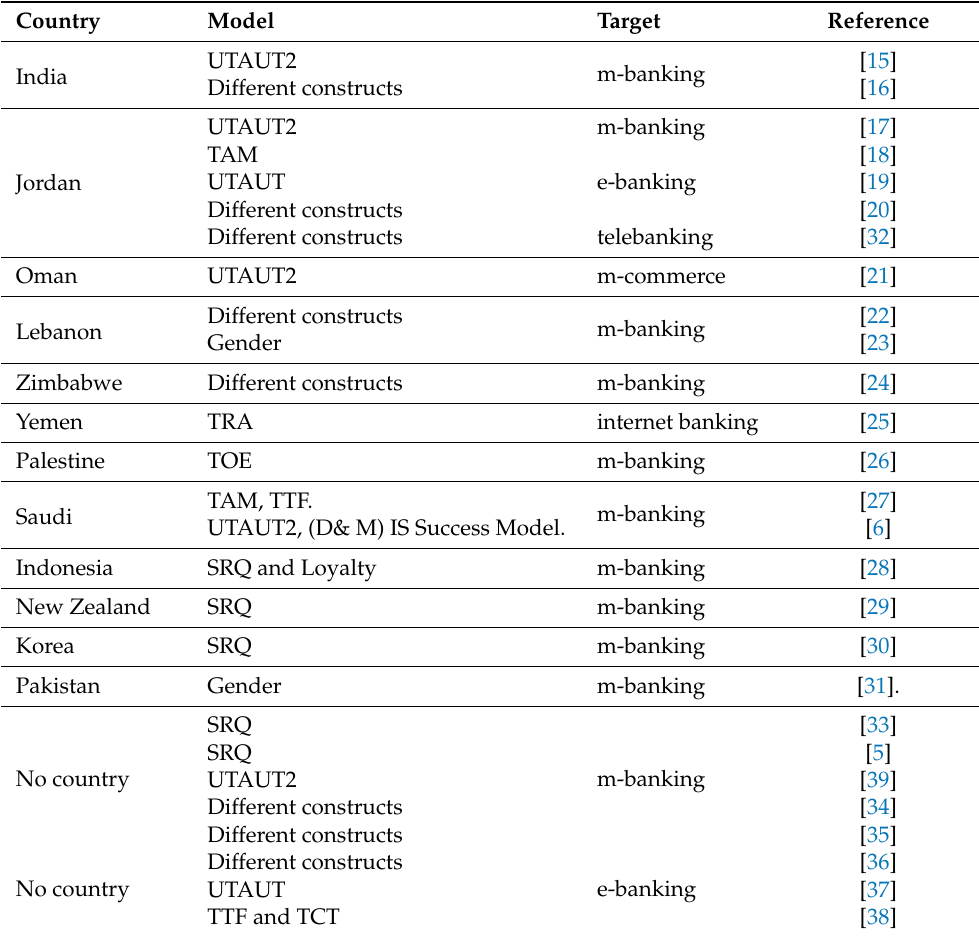
Table 1. Summary of the studies conducted on m-banking using different factors and models.